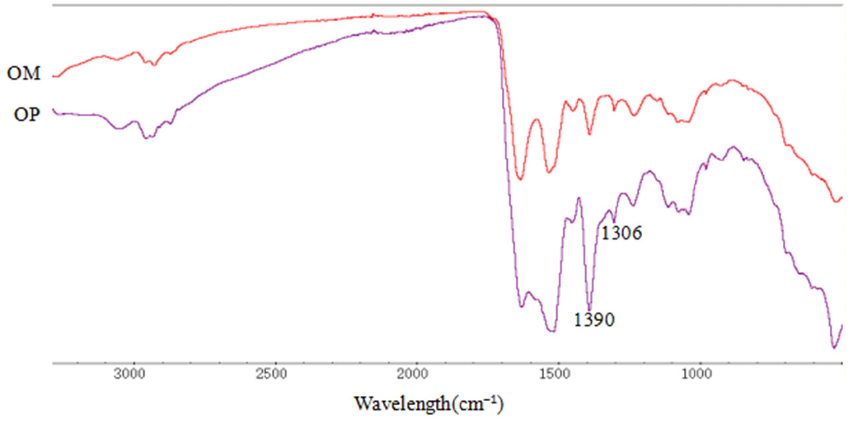
Figure 2. FTIR of OM and OP.